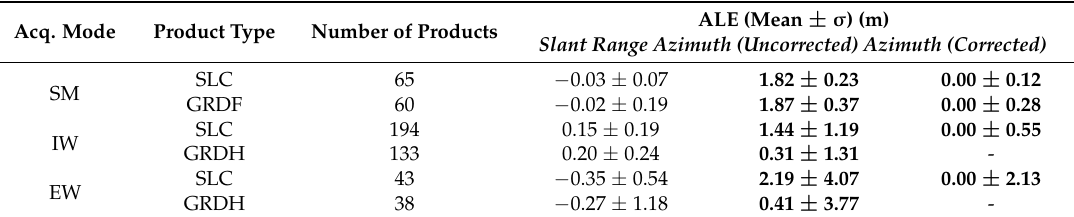
Table 2. Product ALE estimates for S-1A/B acquisitions over Swiss test sites. The right-hand column shows azimuth ALE values after beam-dependent azimuth